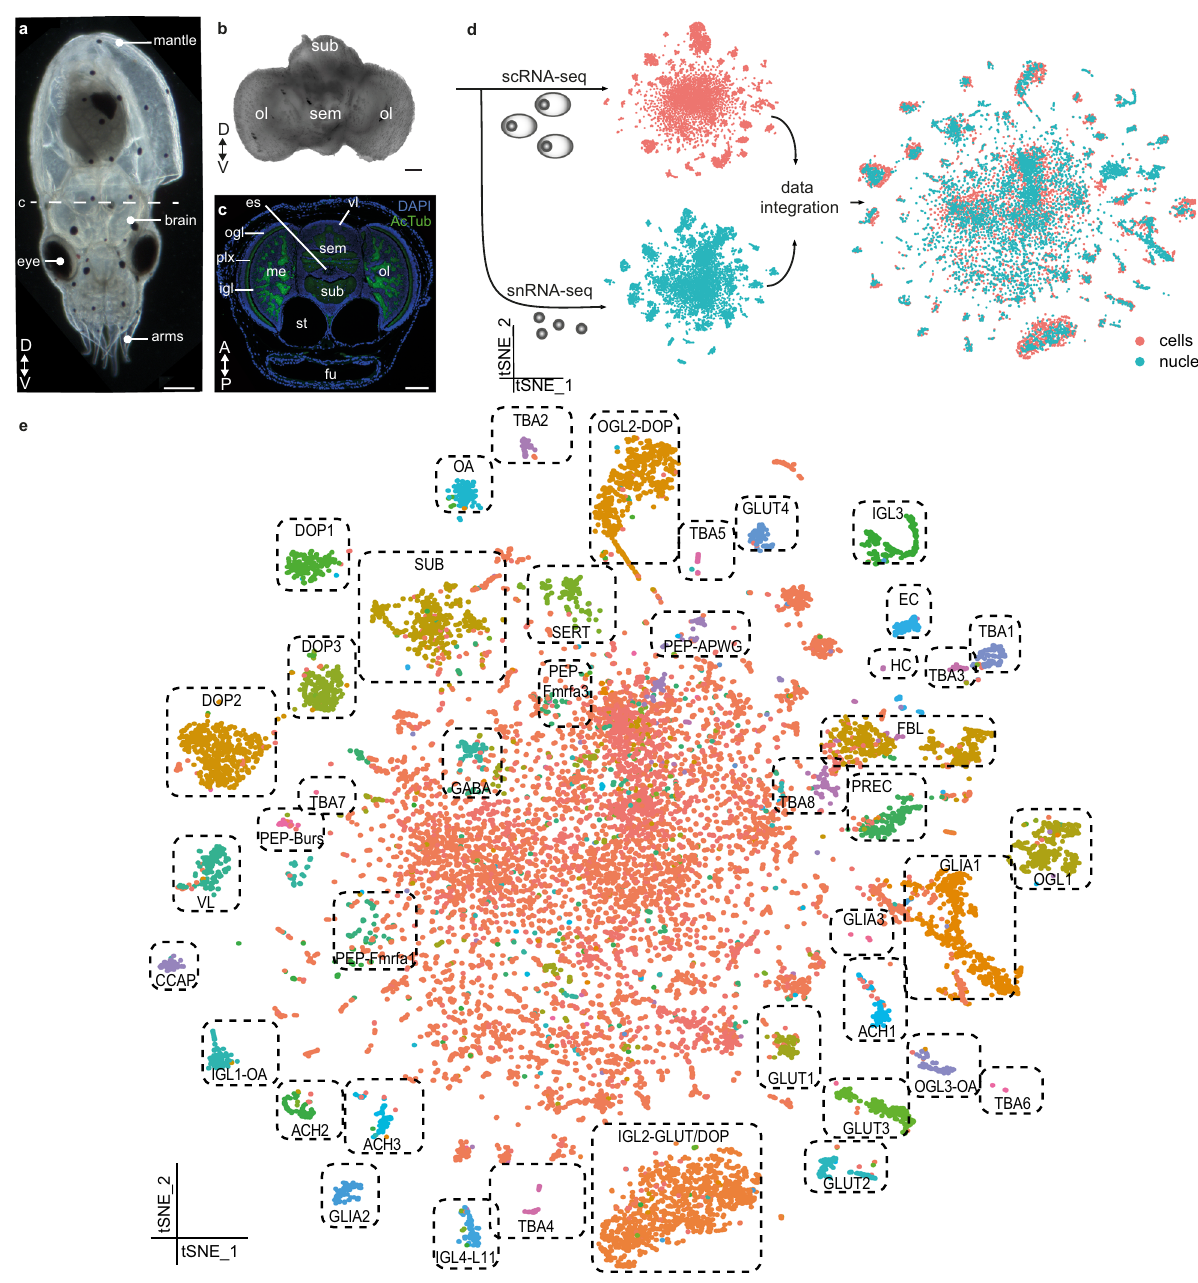
Fig.1|Cellulardiversityinthedevelopingoctopusbrain.a One-day-old Octopus vulgaris paralarva. The dashed line indicates the sectioning plane in c . b Anterior view of a dissected brain. c Representative transversal section of a larva with annotated anatomical structures. d Experimental design of this study. Single cell andnucleiRNAsequencingwasperformedwith10xGenomicsanddataintegration resulted in a fi ltered dataset of 17,081 high-quality cells. e t-SNE representation of the integrated sc and snRNA-seq data. Annotated cell types are labeled. All scale bars represent 100 µ m. A anterior, ACH cholinergic neurons, AcTub acetylated tubulin, CCAPcardioactive peptidecells, DOP dopaminergicneurons, D dorsal,